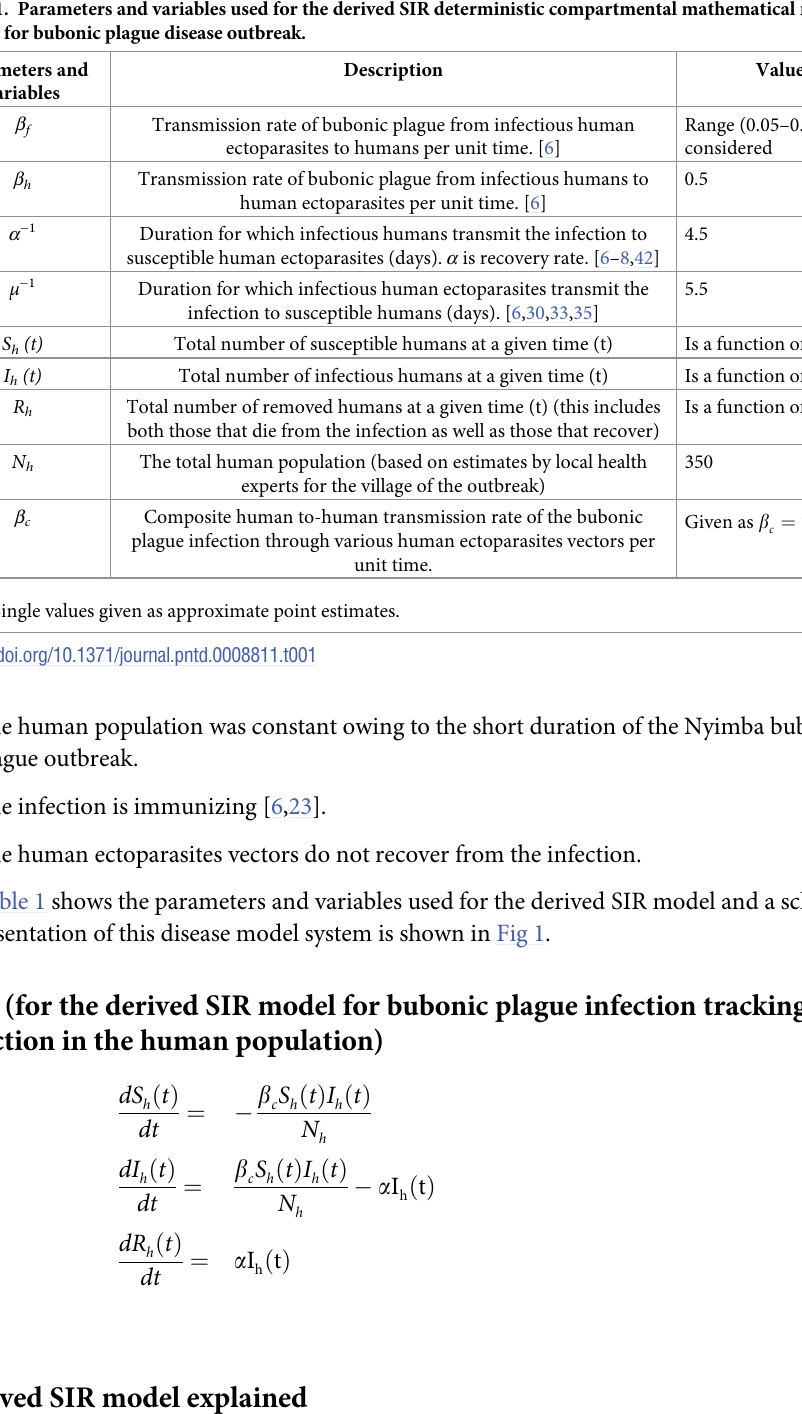
Table 1. Parameters and variables used for the derived SIR deterministic compartmental mathematical model system for bubonic plague disease outbreak. Parameters and variables